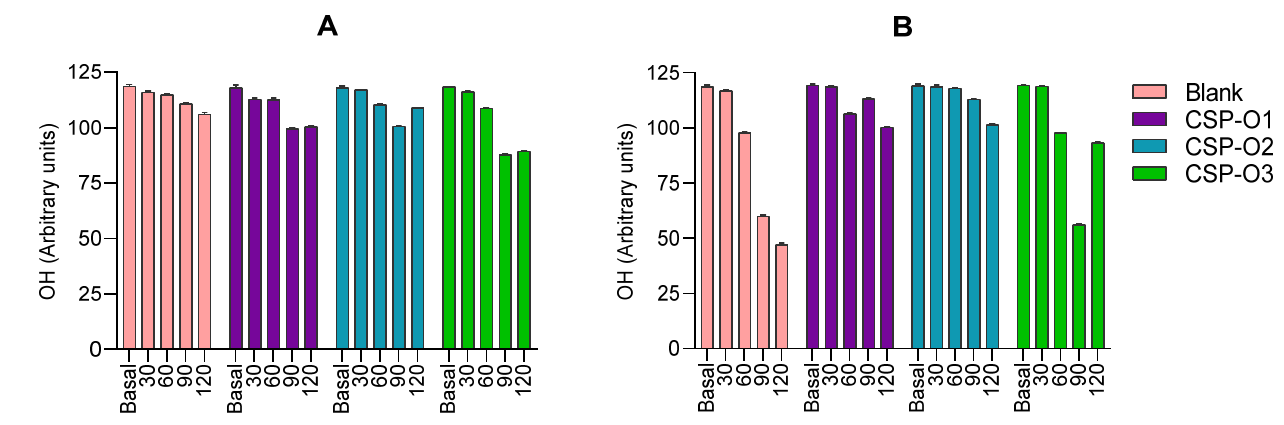
Figure 4. Ocular hydration values obtained after a two-hour application of the samples to ( A ) the corneal membrane and ( B ) the scleral membrane. Each value represents the mean ± SD ( n = 10). All formulations at all times, with the exception of basal, show statistically significant differences ( p < 0.001).